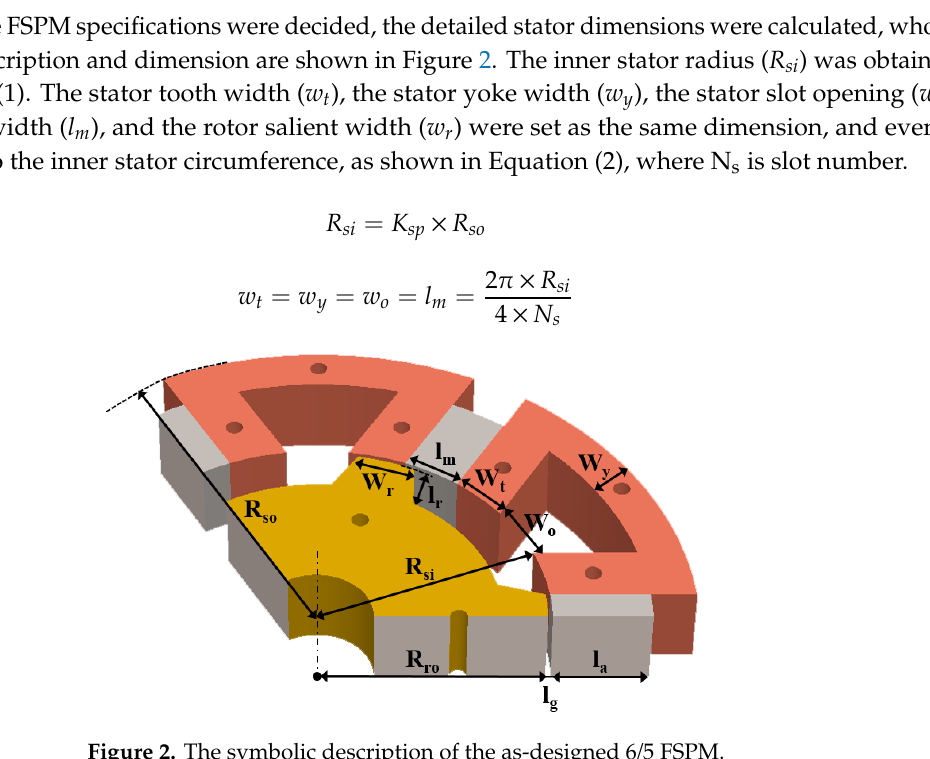
Figure 1. The schematic diagram of 6 ‐ slots/5 ‐ poles (6/5) flux ‐ switching permanent magnet (FSPM).